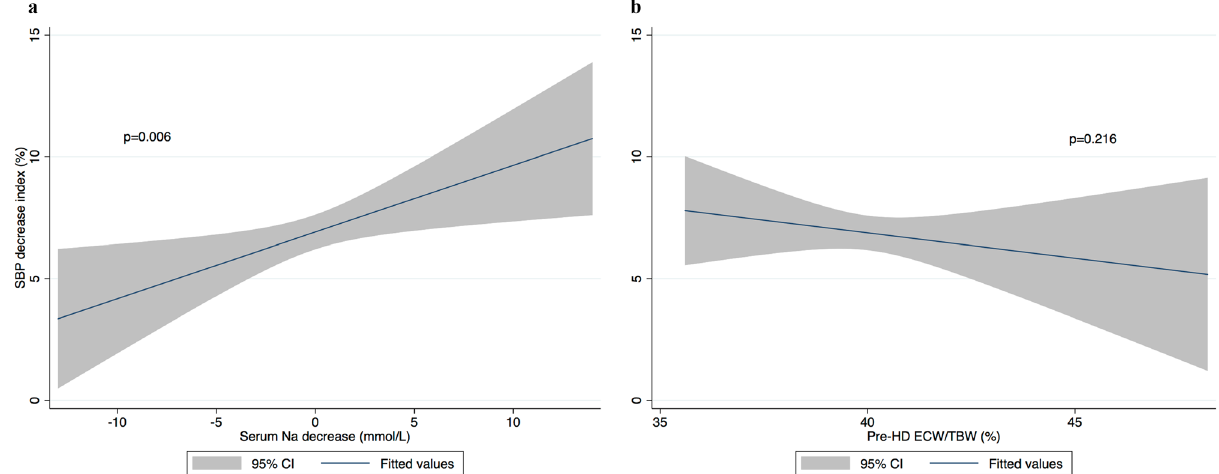
Figure 1. Multivariate relationship between SBP decrease index (%), serum Na decrease (mmol/L) and pre-HD ECW/TBW (%). ( a ) SBP decrease index (%) and serum Na decrease (mmol/L). ( b ) SBP decrease index (%) and pre-HD ECW/TBW (%). Relationship is based on the final multivariate model and is thus adjusted for: age, square of age, BMI, antihypertensive medication, serum albumin, dialysis vintage, dialysate calcium, UFR and Kt/V. Blue line represent fitted values and grey area represent 95% confidence interval. SBP systolic blood pressure, Na sodium, HD haemodialysis, ECW extracellular water, TBW total body water, BMI body mass index, UFR ultrafiltration